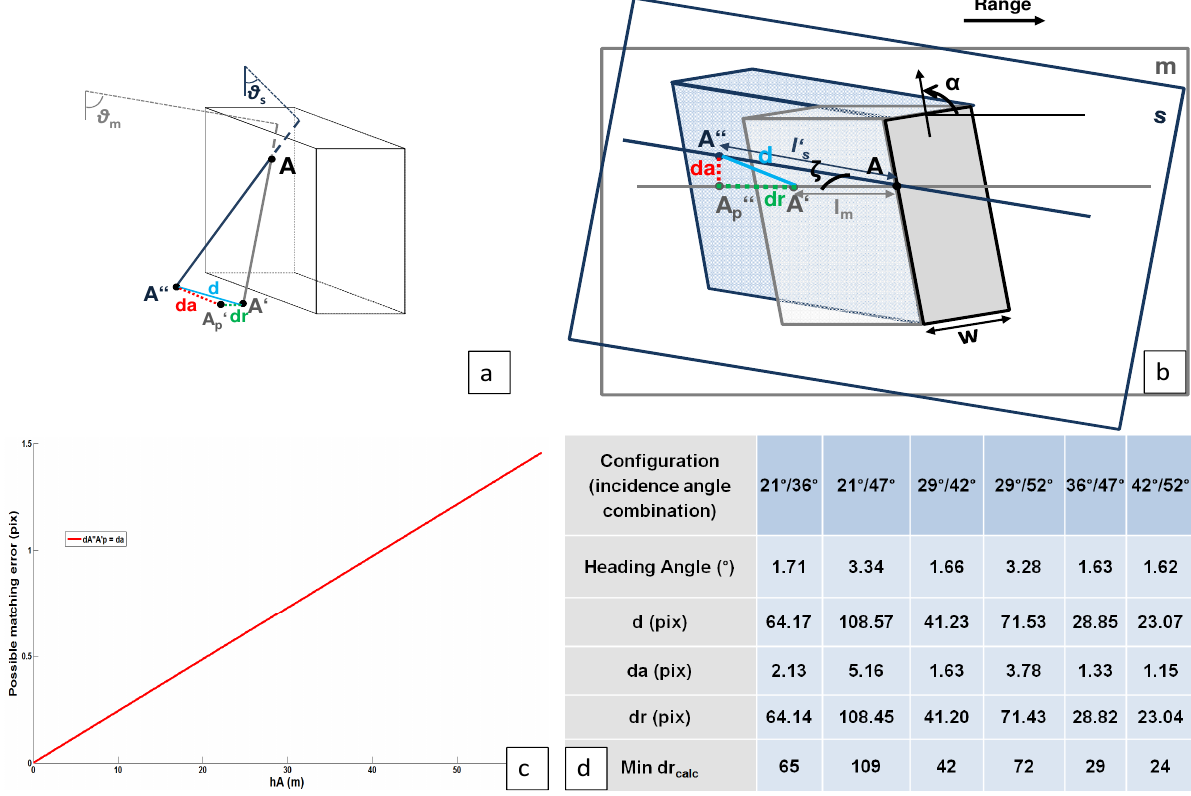
Figure 2: Influence of the heading angle ζ on the coregistration; a) 3D representation of the facade point A mapped in ground geometry; b) schematic representation in top view in slant-range geometry; c) result for configuration 21°/52°; c) overview of the pixel disparities for h=40m, for same-side configurations.   ll   dr −  = 22min tempsearch    calc Values of min dr calc can be found in the last row of Figure 2c. It represents the maximum disparity value that can be determined using l search and l t emp . But, in order to retrieve the correct building height, min dr calc should have at least the values of Figure 2c. Namely, the acquisition configuration induces the offset dr that has to be recovered in order to determine the